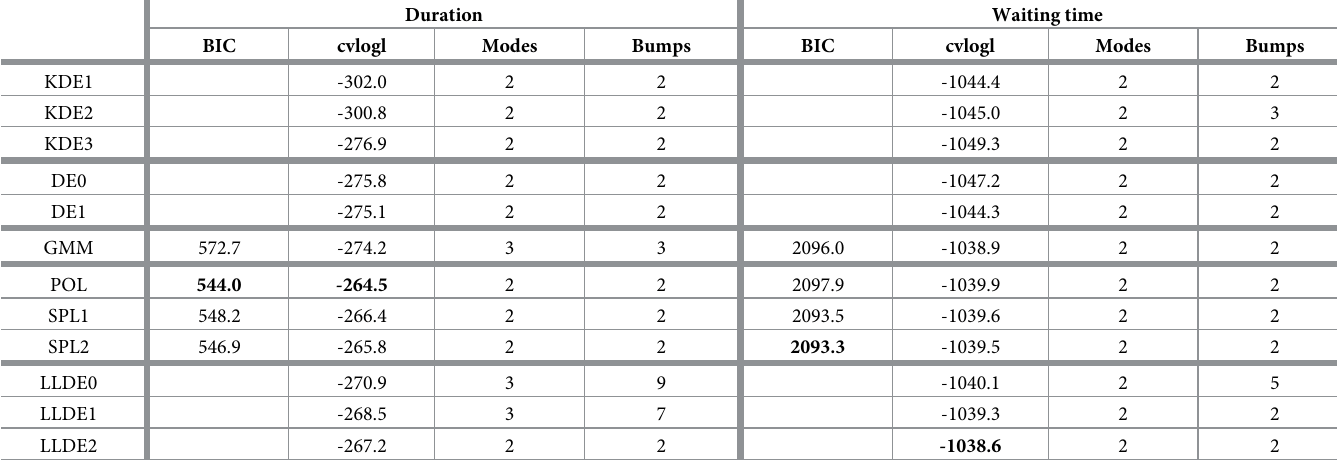
Table 10. Old Faithful geyser data: Bayesian information criterion, cross-validated log-likelihood, number of modes and number of bumps for various density esti- mators. The number of modes and bumps is counted on the interval [1.25, 5.5] for the eruption duration data and on the interval [35, 100] for the waiting time data. The best method is indicated in